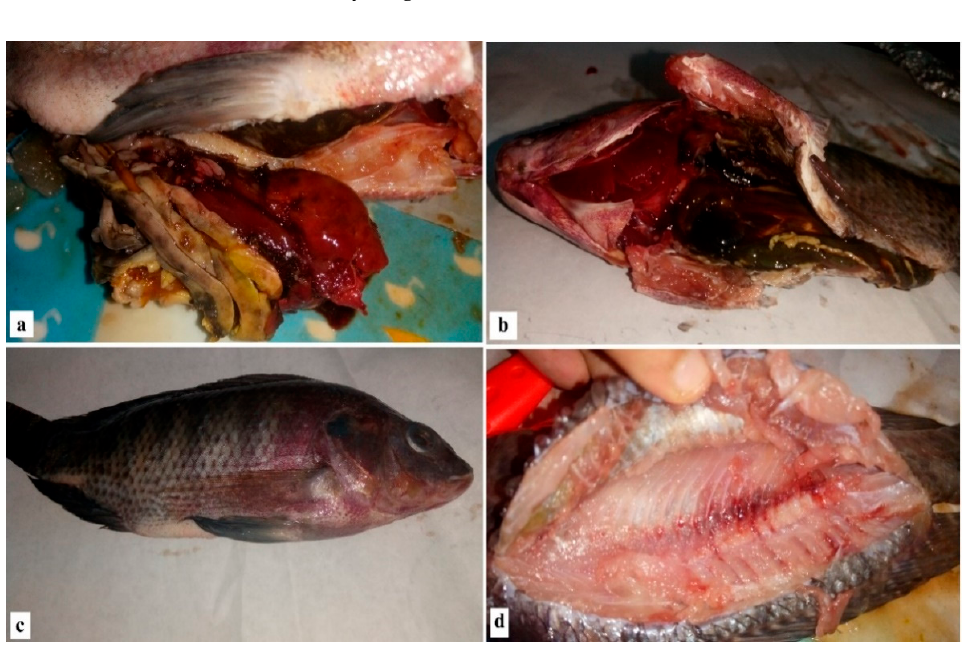
Figure 1. Clinical signs and postmortem examination of diseased Nile tilapia.